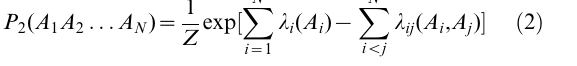
Figure S4 Distribution of pair correlation model prob- abilities for sequences in the tail of the Lee distribution that are observed (red) or unobserved (blue) in the Stanford database. The histogram in red is the distribution of pair correlation model probabilities for sequences found in the tail of the Lee database that also exist in the Stanford database. The histogram in blue is the distribution of pair correlation model probabilities for sequences that are not observed in the Stanford database. The null hypothesis which states that the means of these two distributions are equal, has a low p-value of v 10 { 4 , indicating that the null hypothesis must be rejected. Therefore, the difference between the means of these two distributions is statistically significant. Figure S5 Distribution of the number of sampled sequences not observed in the Lee database. 13,286 sequences, corresponding to the size of the Stanford database, were randomly sampled from the probability distribution de- scribed by the pair correlation model. The distribution of the number of sequences not observed in the Lee database for each of the 1,000 simulations, is plotted as a frequency distribution. The sample average for this distribution is 124.2 and the standard deviation is 10.6. The actual number of sequences in the Stanford database that are not observed in the Lee database is 128 (plotted as a straight red line), a number which lies well within 1 standard deviation of the sample mean. Figure S6 Distribution of the number of unique se- quences for sample sizes equal to the size of Stanford and Lee databases. 13,286 and 45,161 sequences, correspond- ing to the sizes of the Stanford and Lee databases, were each randomly sampled from the probability distribution described by the pair correlation model. The distribution of the number of unique sequences for 1,000 simulations for both sampling distributions is plotted as a histogram. The sample average for the Stanford-sized sample distribution is 452.9 and the standard deviation is 14.3. The sample average for the Lee-sized sample distribution is 862.1 and the standard deviation is 18.7. The number of unique sequences in the Stanford database is 431 while the number of unique sequences in the Lee database is 828, both of which lie within 1.4 standard deviations of their respective Figure S2 Comparison of sequence probabilities under sample means. the independent and pair correlation model. The proba- bility of a given sequence under the pair correlation model, P 2 , is plotted against the probability of the same sequence under the Figure S7 Structure of HIV protease subtype B and the independent model, P 1 , for all sequences with 1 through 6 electrostatic spatial distances between highly correlated pairs. The mutations. Both independent and pair correlation model probabilities backbone structure of HIV protease subtype B (PDB ID: 1NH0) is are renormalized and are conditional upon the number of mutations. depicted in ribbon format. Similar to Figure 1, the 18 electrostatically active residues are highlighted. Residue positions which have a predominantly negatively charged non-neutral residue in the sequence database are depicted in red. Residues which have a predominantly positively charged non-neutral residue in the database are depicted in blue. Addititionally, the distances between the top 5 most correlated pairs of residues are depicted as dashed lines. The pairs are 30–88, 20–35, 16–63, 18– 20 and 20–92. Figure S3 Comparison between the observed and predicted mutivariate marginals for 2, 3 and 4 muta- tions. Predicted marginals determined using belief propagation in Table S1 Electrostatic mutation patterns with the the Bethe approximation are plotted against the observed highest probabilities under the pair correlation model marginals for sets of 2, 3, and 4 mutations. The correlation and the drug combinations they are most strongly between P bethe associated with. Shown are the top 5 patterns with 2, 3 and ij 4 electrostatic mutations for which the pair correlation model predicted probability, P 2 , is the highest, together with the